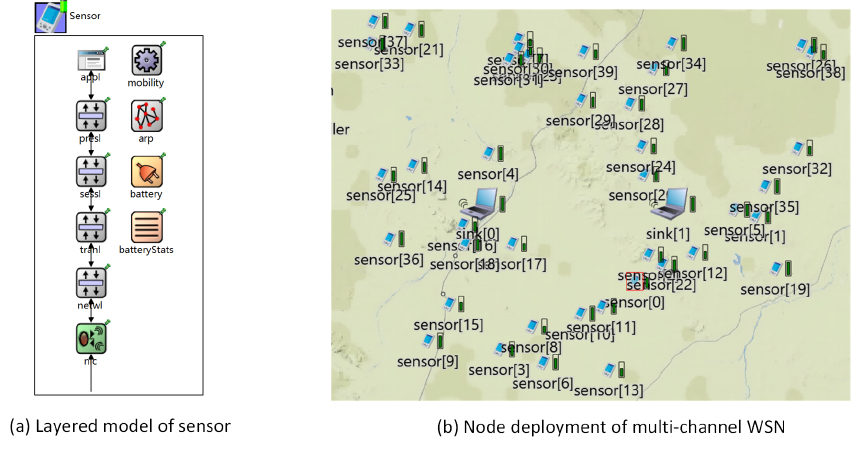
Figure 5. Visualization example of network model on